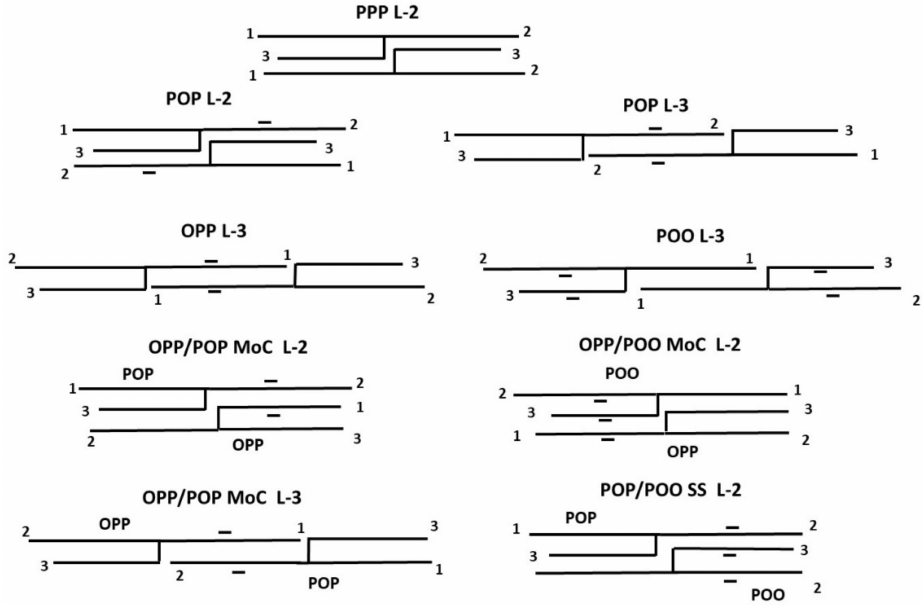
Figure 3. Proposed molecular arrangements for PPP L-2, POP L-2, POP L-3, OPP L-3, POO L-3, OPP / POP MoC L-2, OPP / POO MoC L-2, OPP / POP MoC L-3 and POP / POO SS